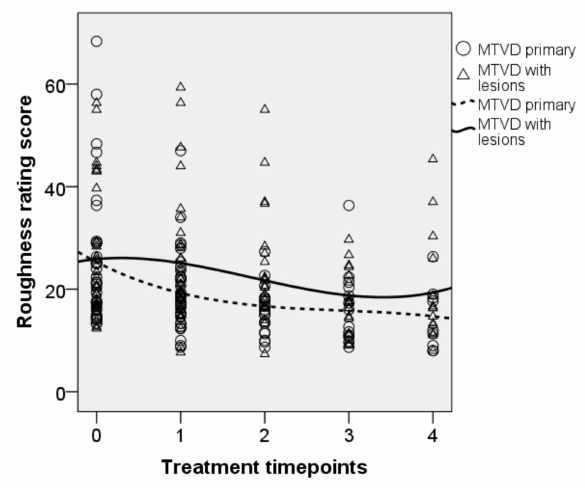
Figure 3. Longitudinal plot of data for the roughness ratings. Trend line is shown for each subgroup. 0 = baseline, 1 = OPT, 2 = SVQ, 3 = SVQ variant, and 4 = NP.